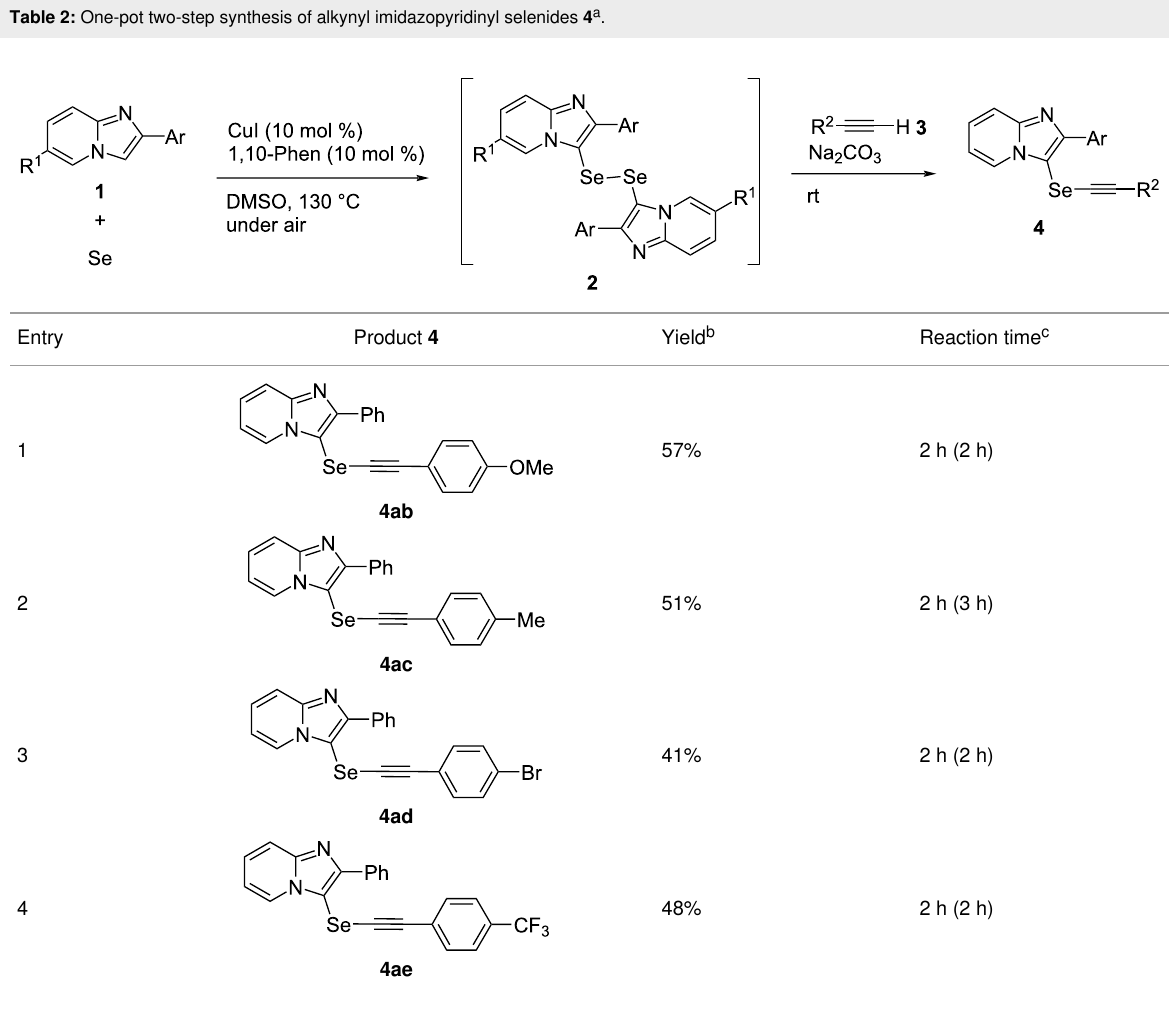
Figure 2: (a) ORTEP drawing of 4aa and (b) its stacking structure.